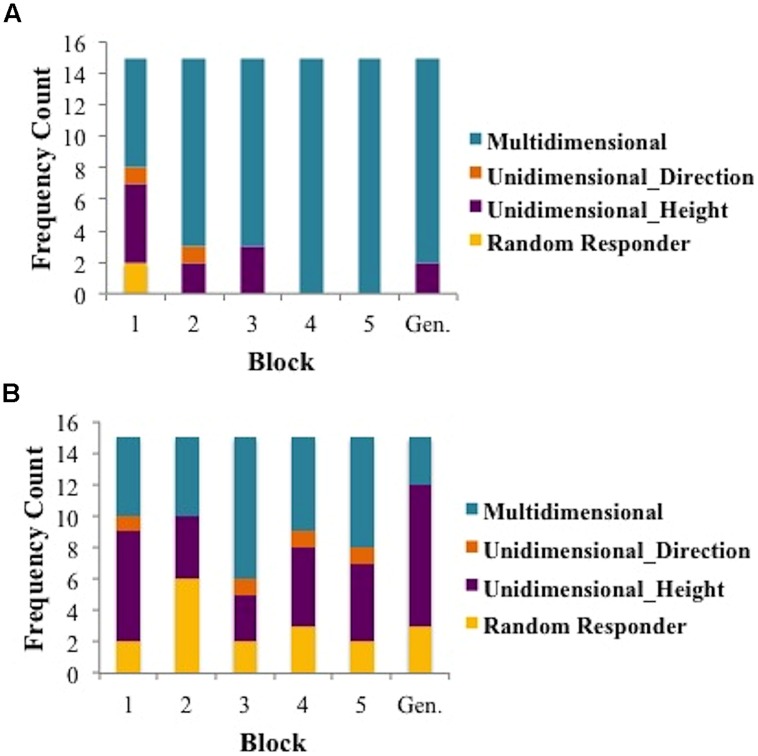
Strategy use counts per block for musicians (A) and non-musicians (B).